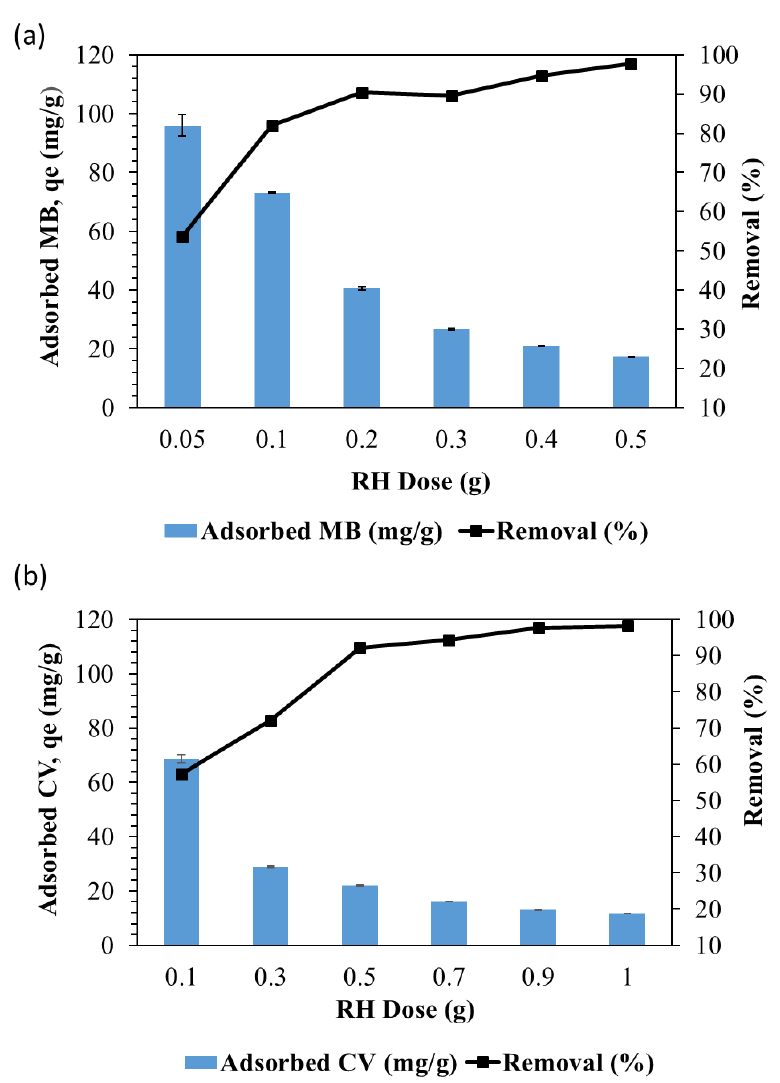
Figure 7. Effect of rice husk (RH) dosage on ( a ) methylene blue (MB) adsorption and ( b ) crystal violet (CV) adsorption